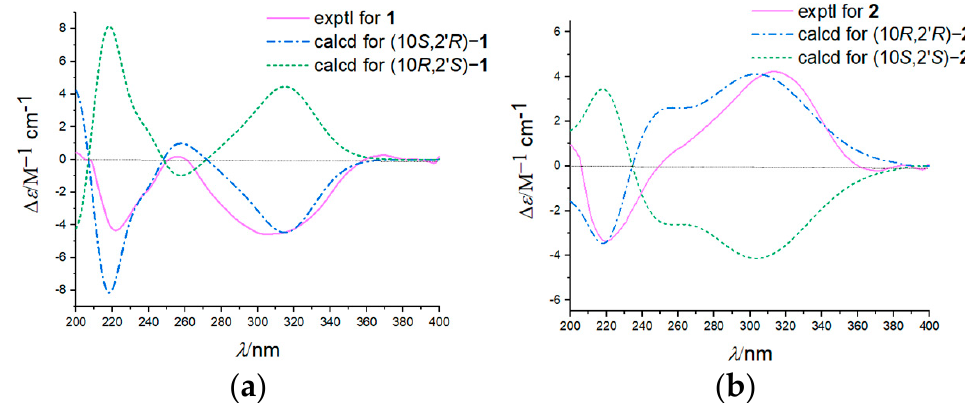
Figure 4. Experimental and calculated ECD spectra of compounds 1 ( a ) and 2 ( b ). Compounds 1 and 2 are a pair of epimers exhibiting the same planar structure with only 2 chiral centers at C-10 and C-2 (cid:48) , suggesting four possible configurations (10 S , 2 (cid:48) R ), (10 R , 2 (cid:48) S ), (10 R , 2 (cid:48) R ) and (10 S , 2 (cid:48) S ). Thus, the absolute configurations were determined by calculating their theoretical ECD and comparing them to the experimental curves and cotton effect values. The theoretical ECD spectrums were constructed by the time- dependent density functional theory (TDDFT) method at the B3LYP/6–311G** level in methanol. The predicted ECD curves of (10 S , 2 (cid:48) R ) − 1 and (10 R , 2 (cid:48) R ) − 2 were matched well with the experimental ones (Figure 4). Furthermore, the experimental ECD curve of (Figure S24) [12]. So, the absolute configurations of 1 and 2 were determined as 10 S , 2 (cid:48) R, shown in Figure 2, and were named amphichoterpenoids D and